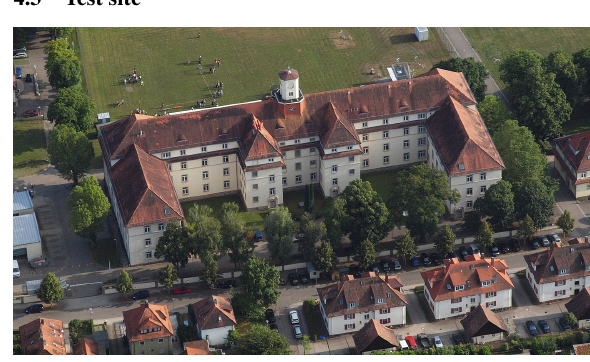
Figure 2. Aerial view of the test site